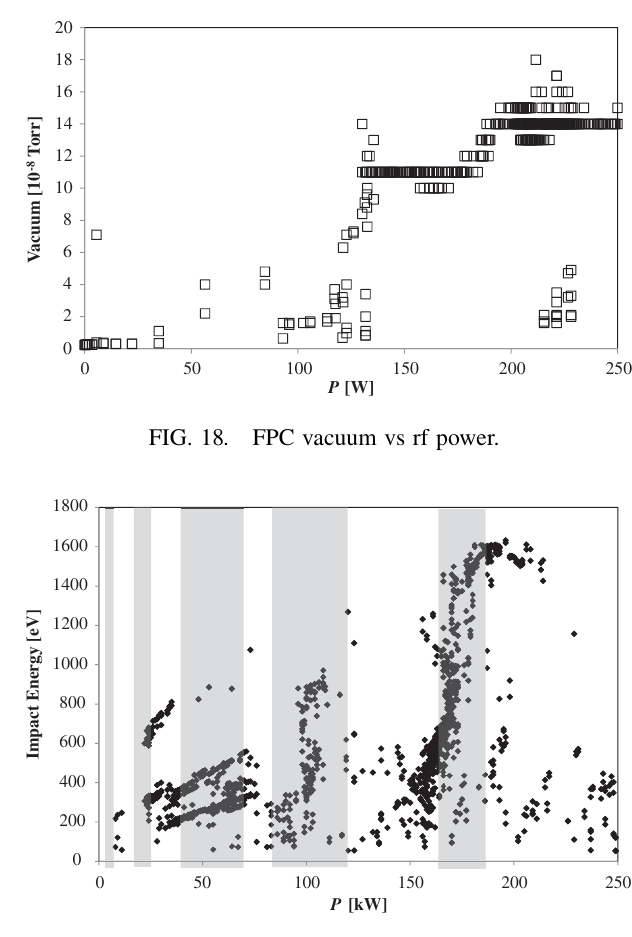
FIG. 19. Comparison of multipacting zones from FPC condi- tioning test (grey-shaded areas) and simulation results at 703.9 MHz with 0 (cid:2) (black